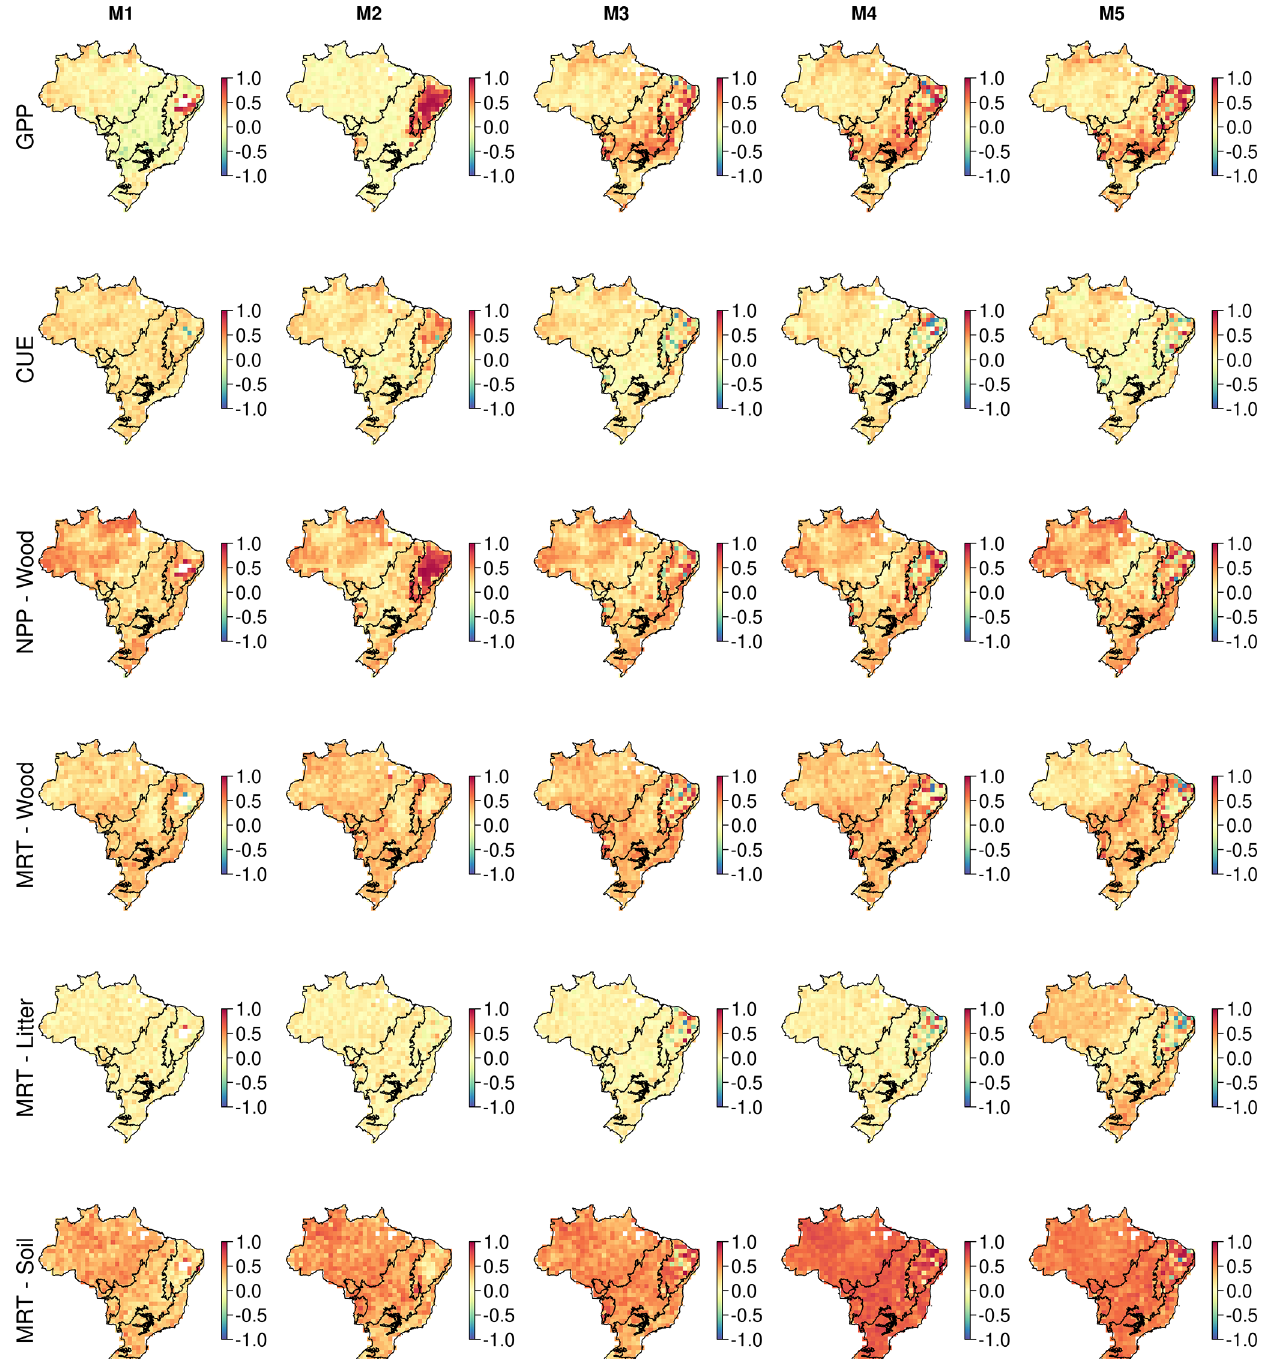
Figure A19. Correlation maps between the simulated change in DOM stocks (SSP2-4.5; 2001–2100) and ecosystem variables. These maps identify spatial variation in the sensitivity of biomass change to key ecosystem variables. Correlates are pool-specific MRT (years), NPP (gCm − 2 d − 1 ), CUE (1 − R a : GPP) and GPP (gCm − 2 d − 1 ) estimated across the whole simulation period.